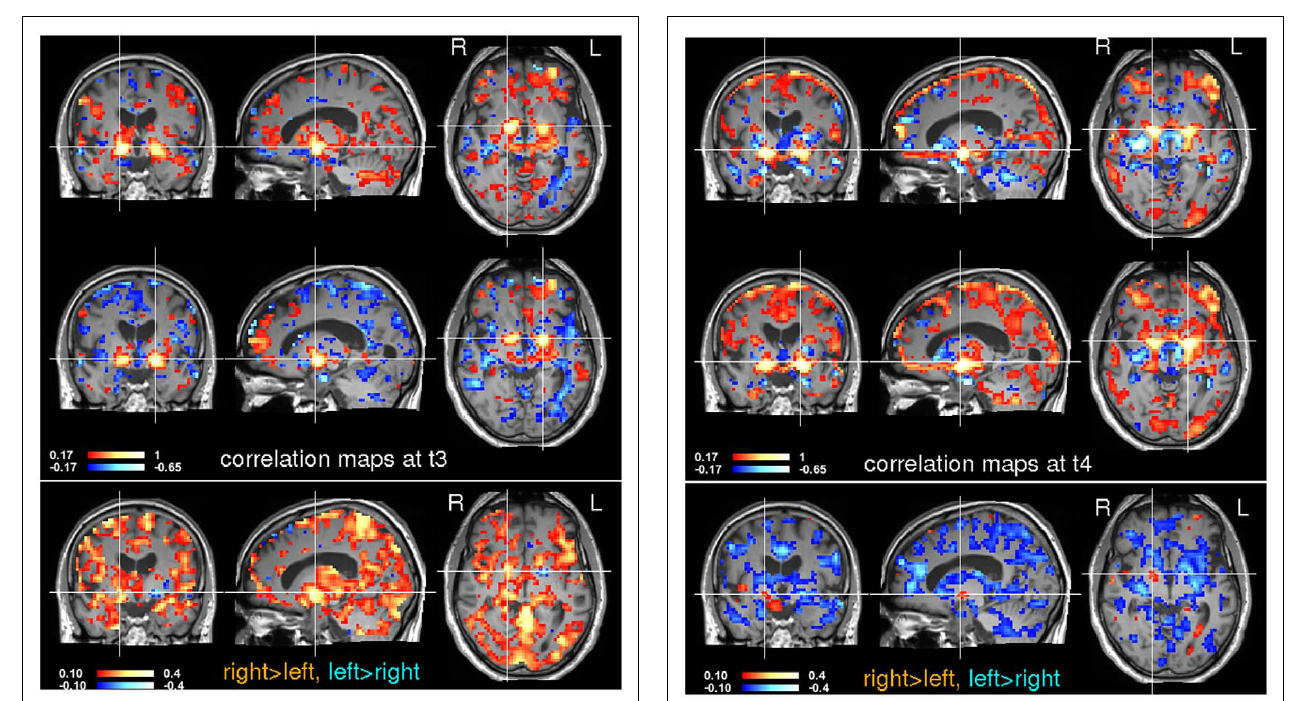
FIGURE 9 | Seed-based correlation analysis at time t4. Voxels in the left and right globus pallidus were used for a subsequent seed-based correlation analysis.The location of the seeds is indicated by the crosshairs. Note that inter-hemispheric differences have changed noticeably between t3 and t4 (see Figure 8